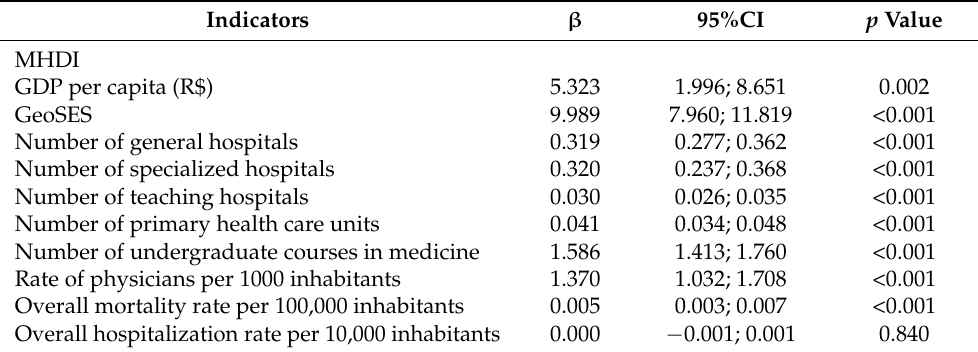
Table 5. Bivariate analysis of the relationship between contextual factors (socioeconomic, structural, and epidemiological) and the number of MRPs. Factors associated with the number of MRPs. North region, Brazil,